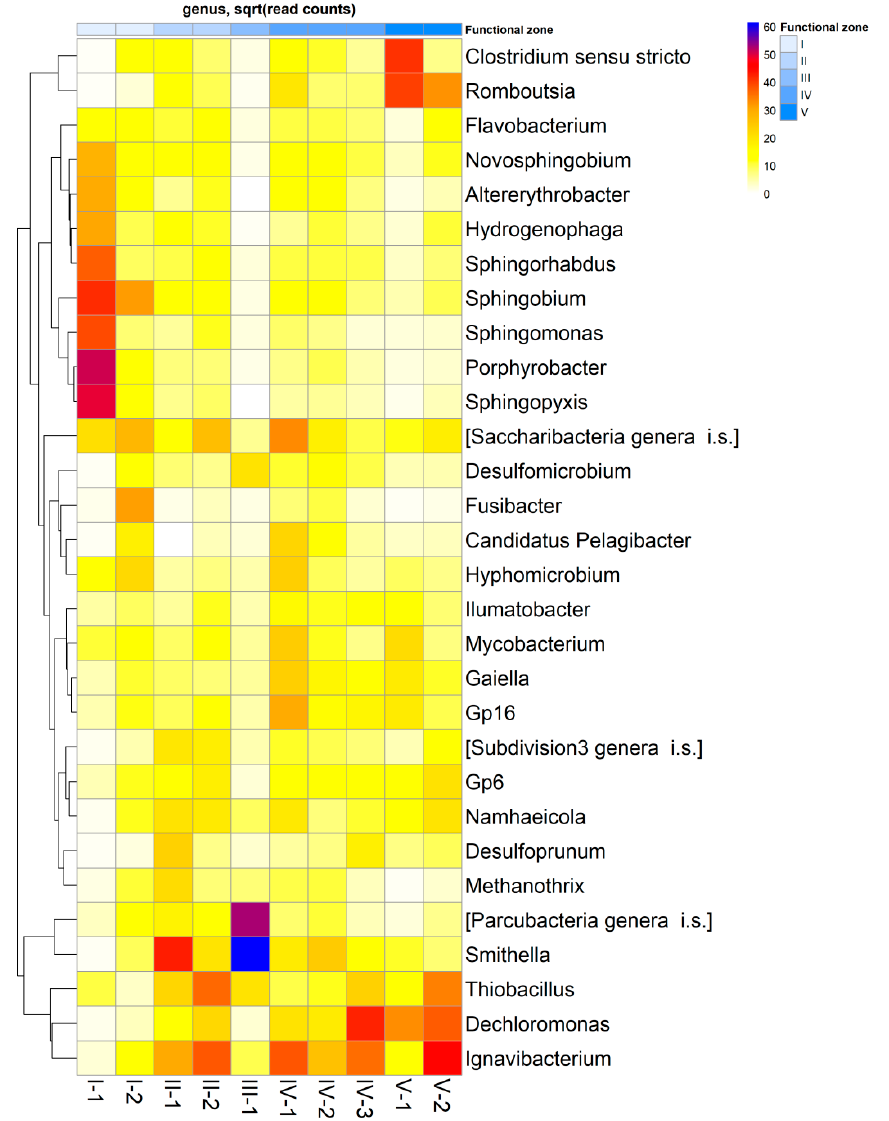
Figure 5. Relative abundances of top 30 microbial taxa of considered functional zones of the constructed wetland at the genus level. The data is given as square roots of the read counts. Abundances of prokaryotic genera increase in a row: white–yellow–red–violet–dark blue. Relative abundances of many microbial taxa were strongly correlated to the physical characteristics of particles in the sediments (diameter and surface area of particles, the proportion of different size fractions) (Table 3). Most of bacterial phyla (Acidobacteria, Bacteroidetes, Chloroflexi, Firmicutes, and Verrucomicrobia) were positively correlated to the surface area of particles and to the particles of average (1–100 µ m) and low ( < 1 µ m) diameters (Table 3). Almost all classes and genera of Acidobacteria were confined to small-diameter particles. Alphaproteobacteria was the only bacterial class that was very strongly correlated to the large particles of 100 to 1000 µ m (r = 0.93) and > 1000 µ m (r = 0.87) diameters. At the genus level, most of these Alphaproteobacteria belong to the Sphingomonadales order: Altererythrobacter , Novosphingobium , Sphingobium , Sphingomonas , Sphingopyxis , and Sphingohabdus (Table